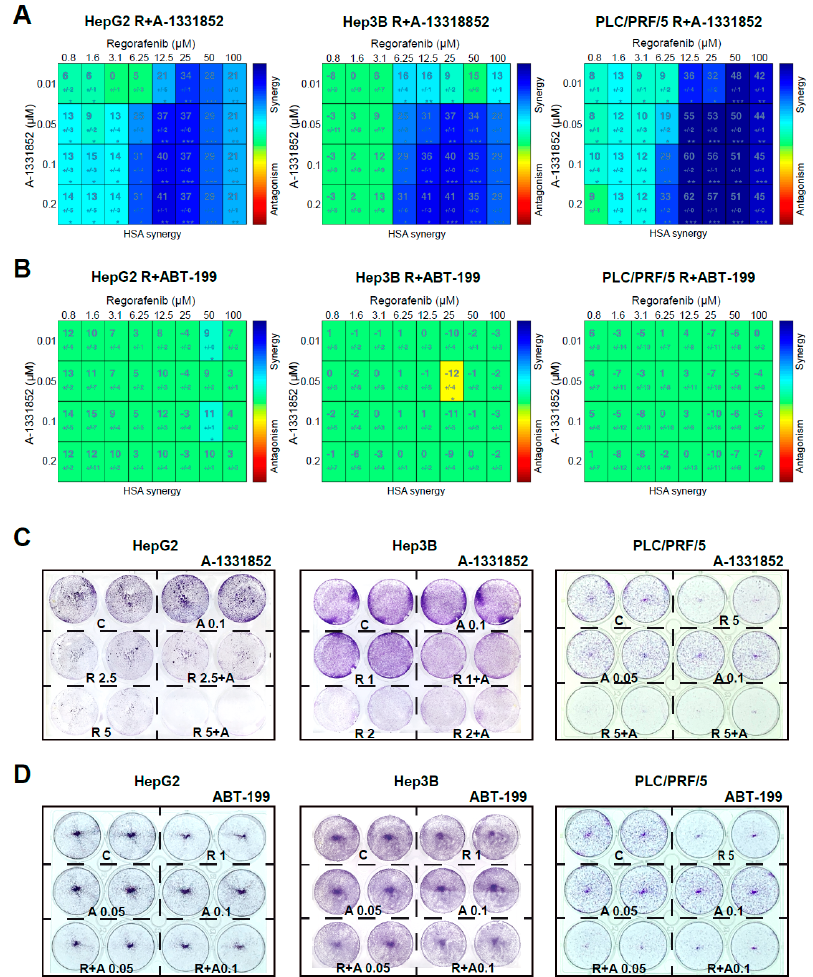
Figure 3. A-1331852 synergistically increased regorafenib cytotoxicity against di ff erent hepatoma cell lines. ( A , B ) MTT assays to test the A-1331852 and ABT-199 e ff ect on regorafenib cytotoxicity in di ff erent liver cell lines (HepG2, Hep3B, and PLC / PRF / 5) were performed, synergy calculated using HSA analysis, and results displayed with heat maps (blue synergy vs. red antagonism). ( C , D ), Crystal Violet staining was performed after 3 days of treatment with vehicle ( C ), regorafenib (R), and / or A-1331852 / ABT-199 ( A ) in HepG2, Hep3B, and PLC / PRF / 5 cell cultures. (n = 3) * p < 0.05 vs.